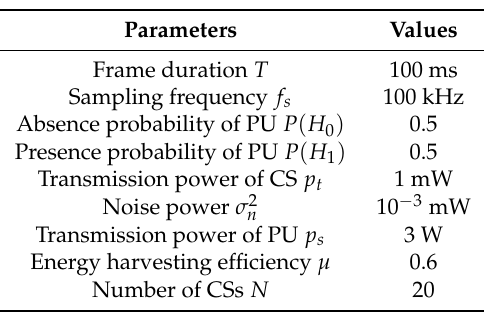
Table 1. Simulation parameters setting.